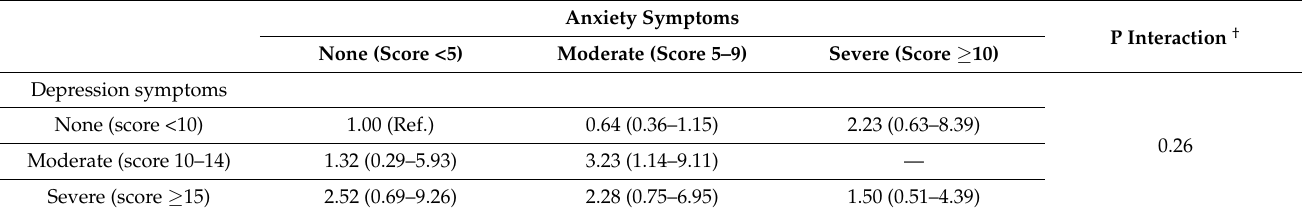
Table 2. Adjusted hazard ratio and 95% confidence interval for the interaction between depression and anxiety symptoms and total mortality among 598 ovarian cancer patients